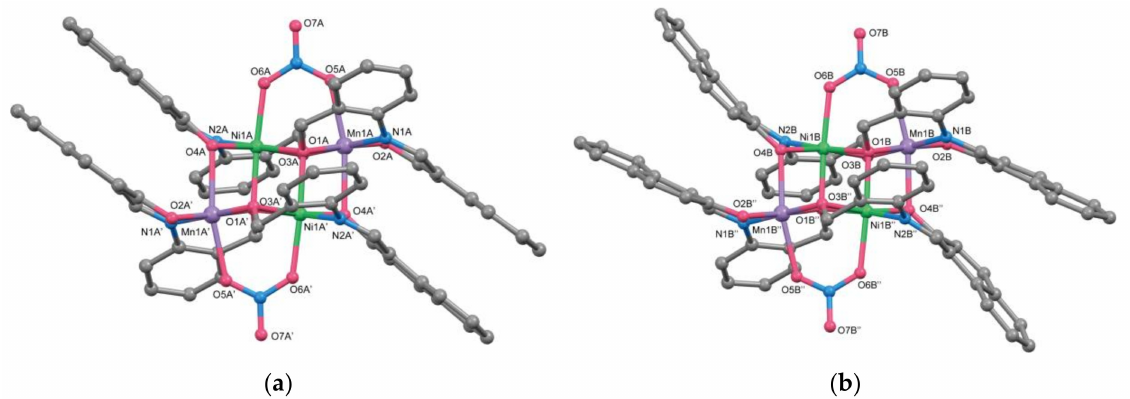
Figure 3. Perspective views of 2A ( a ) and 2B ( b ). Hydrogen atoms are omitted for clarity. Symmetry code: (’) − x + 2, − y , − z + 1; (”) – x + 2, − y + 1, − z +